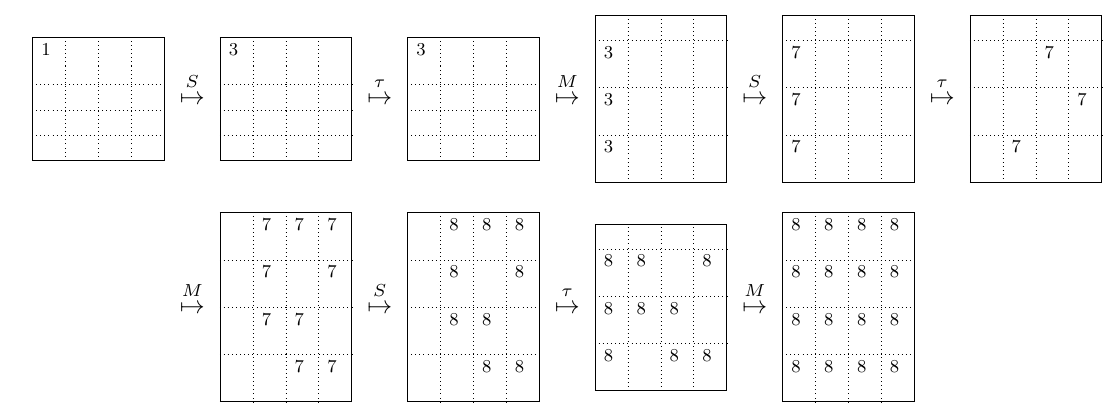
Figure 8: Three-Round Full Diffusion